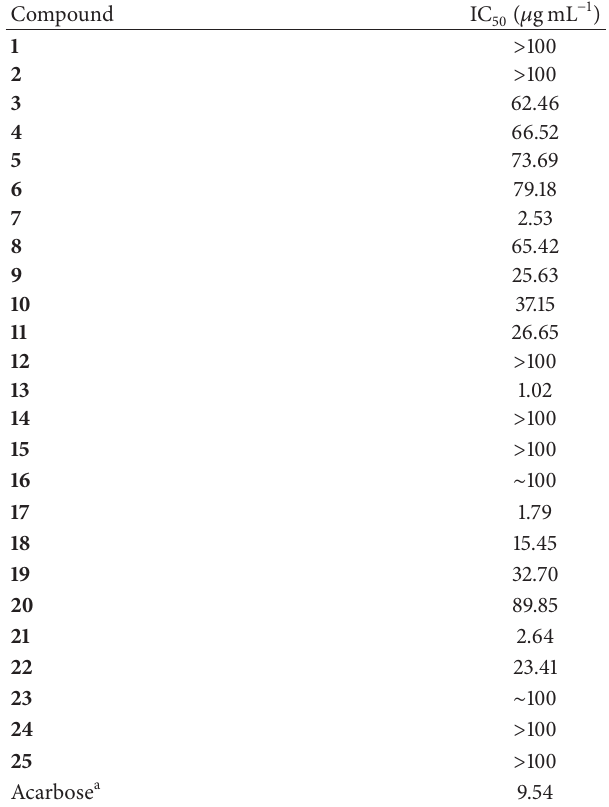
Table 4: Amylase inhibiting activity of individual phenolic com-